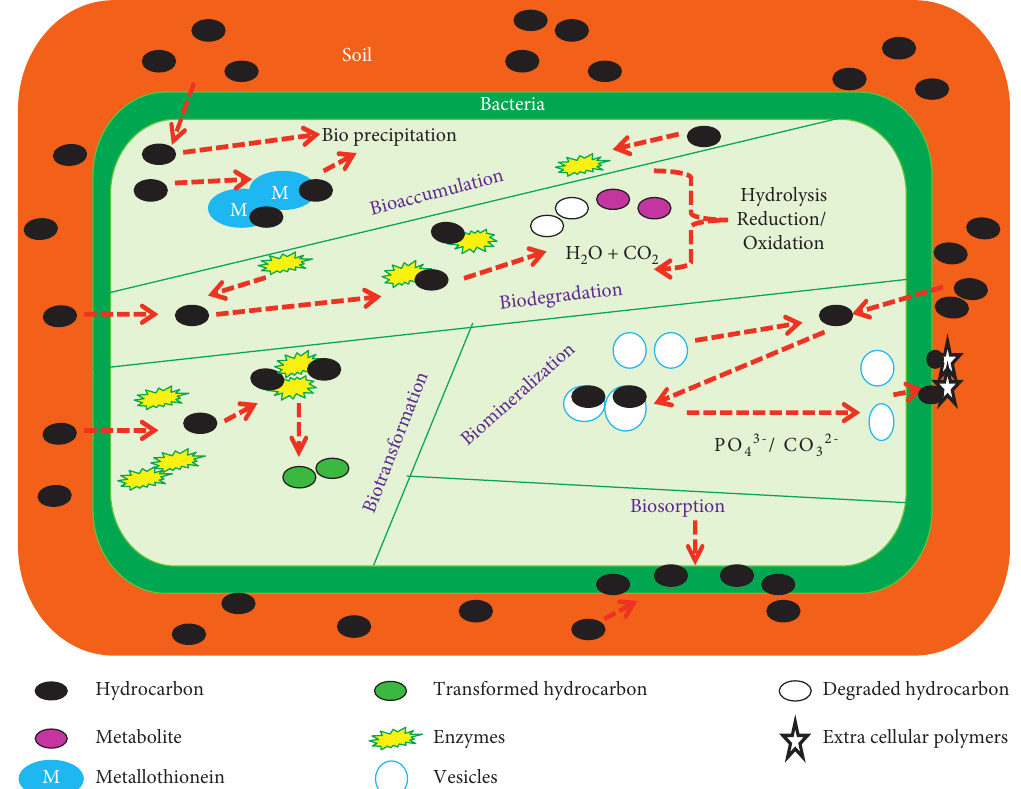
Figure 2: The mechanisms of microbial remediation used for reducing heavy metals